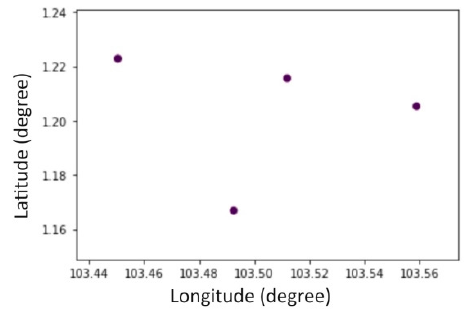
Figure 8. Result of DBSCAN at 1800.